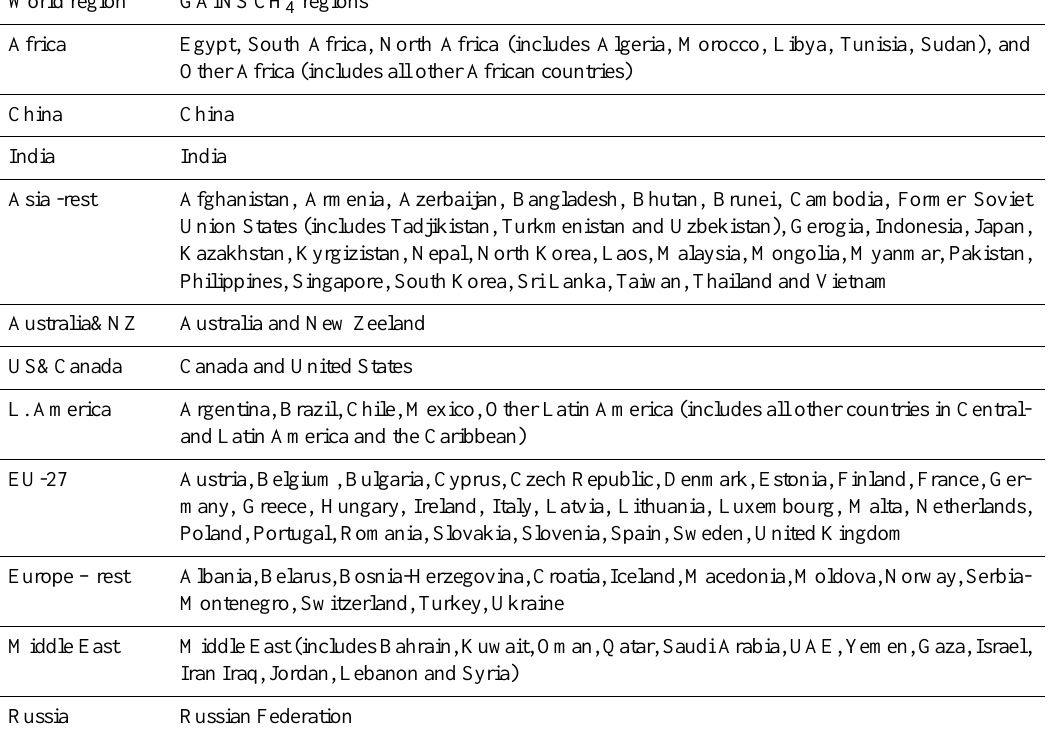
Table 5. Regional aggregations of CH 4 emission estimates in GAINS. World region GAINS CH 4 regions Egypt, South Africa, North Africa (includes Algeria, Morocco, Libya, Tunisia, Sudan), and Other Africa (includes all other African